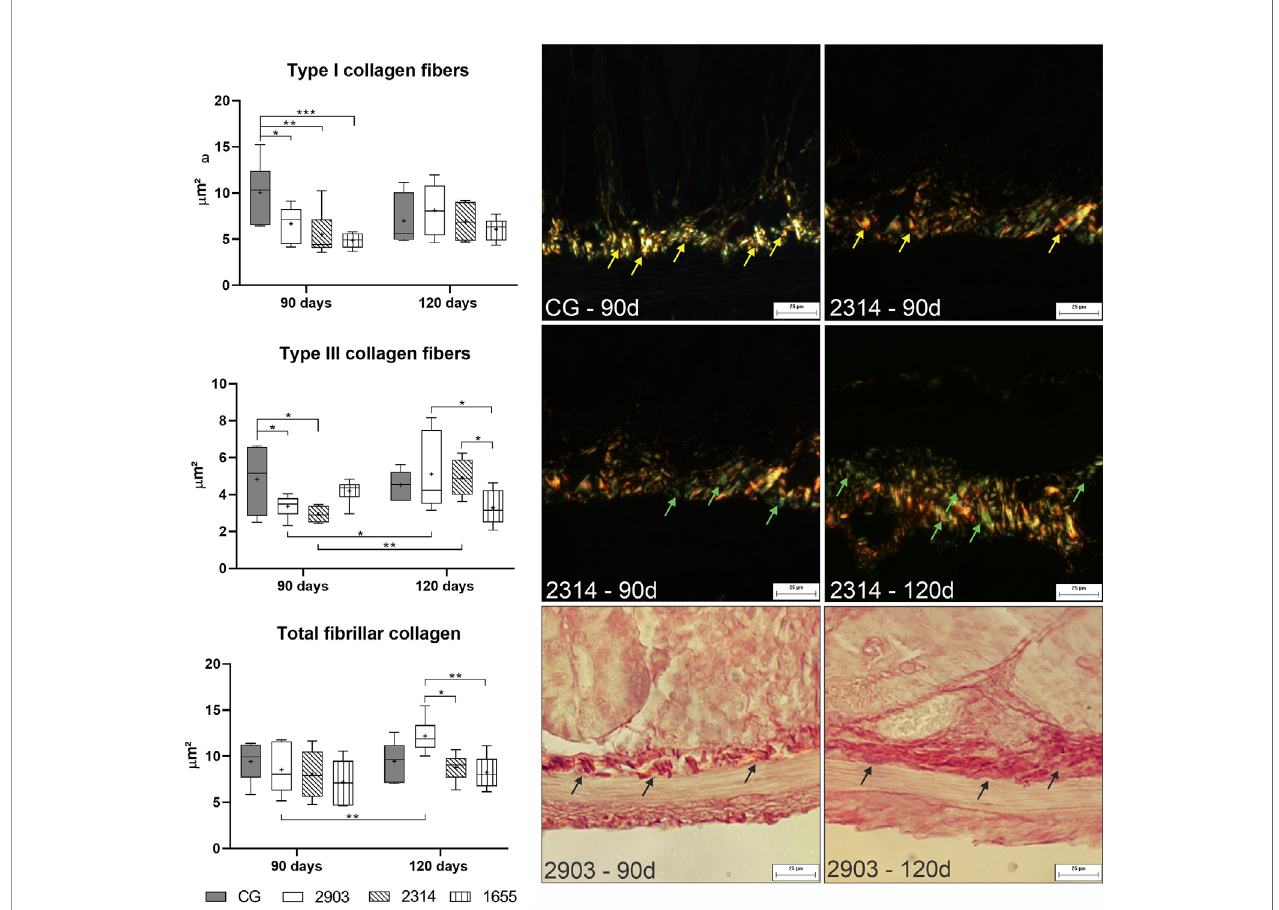
FIGURE 9 | Area occupied by type I, type III, and total fi brillar collagen fi bers ( m m 2 ). Data represented in box plots (median with 25 to 75 percentile), whiskers (2.5 to 97.5 percentile), and mean (+) ( n = 6). * p < 0.05; ** p < 0.01; *** p < 0.001. Photomicrograph of the area occupied by type I collagen fi bers (yellow arrow) in control group and 2314 at 90-days post infection; by type III collagen fi bers (green arrow) in group 2314 at 90- and 120-days post infection; and of total fi brillar collagen (black arrow) in group 2903 at 90- and 120-days post infection (Picrosirius Red staining, 20× magni fi cation, scale bar = 25 μm, Olympus BX50). CG, control group. 2903: group infected with MHOM/BR/1975/M2903. 2314: group infected with MHOM/BR/2003/2314. 1655: group infected with MHOM/BR/2000/1655.